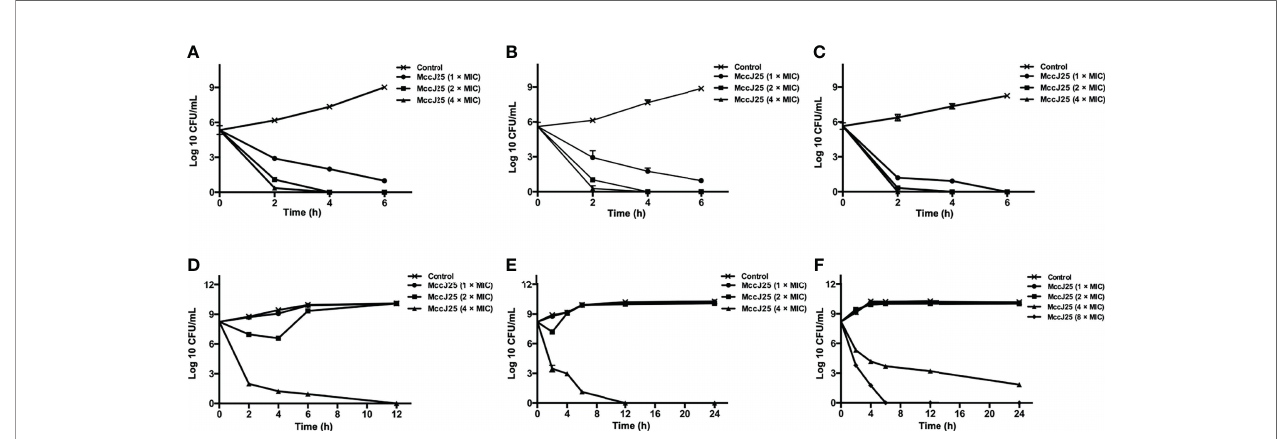
FIGURE 1 | Bactericidal activity assay of MccJ25 against E coli K88. Different concentrations of E coli K88 were cultured in LB containing different levels of MccJ25. E coli K88 cells (5 × 10 5 CFU/mL) were incubated and grown to different stages, including early-log (A) , late-log (B) and stationary (C) phases. Additionally, bacteria, 5 × 10 8 CFU/mL, were cultured and grown to early-log (D) , late-log (E) and stationary (F) phases. Data are means ± standard error of mean from 6 biological replicates.